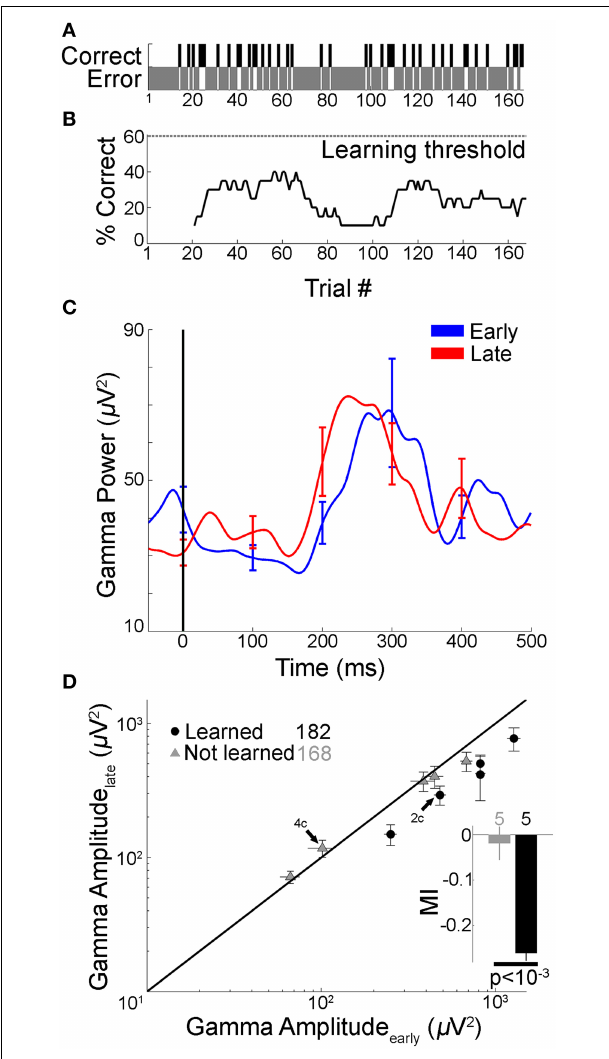
FIGURE 4 | Gamma frequency band amplitude remained unchanged if subject did not learn. In four subjects that did not learn the tasks, < 1% of the electrodes showed changes in gamma band amplitude with learning. In order to directly compare changes in gamma-band amplitude with behavioral performance in the same electrodes we report results from one example subject that participated in two sessions of Task 1: in one of those sessions the learning criterion was not reached. (A,B) Performance for a subject who participated in two sessions of Task 1 (green lines in Figure 1C ). In one session, the subject reached the learning criterion (maximum performance was > 90%, shown in Figures 2A,B ). In the other session, shown here, the subject did not reach the learning criterion (maximum performance < 40%). The format is the same as in Figures 2A,B . (C) Mean gamma frequency band power averaged over the early and late trial blocks (each 20 trials), for the same electrode in Figure 2C , shown here during the session where the learning criterion was not reached. Figure format is the same as Figure 2C . The gamma frequency band amplitude was not significantly different between early and late trials ( p = 0 . 32, rank sum test). (D) Five out of 69 electrodes in this subject showed significant changes in gamma frequency band amplitudes ( p < 0 . 01) between early and late trials in the session where there was learning compared to zero electrodes in the session where there was no learning. Here we compare the gamma frequency band amplitudes during